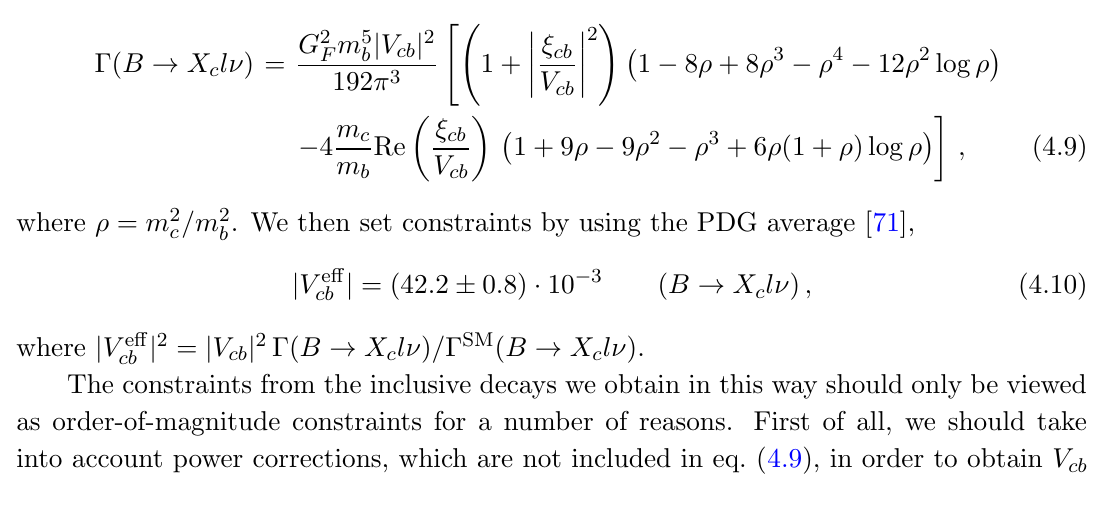
FLAG averages in table 8. Angular distributions in B ! D (cid:3) l(cid:23) information on the Lorentz structure of the W bc vertex